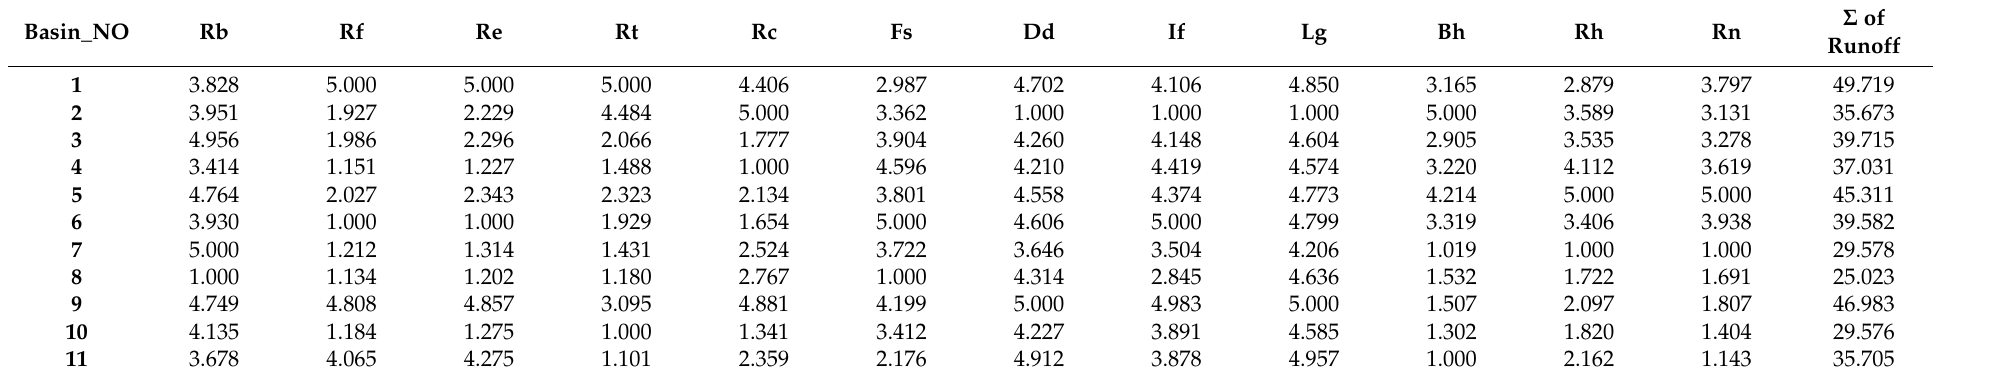
Table 3. The computed runoff degree from morphometric